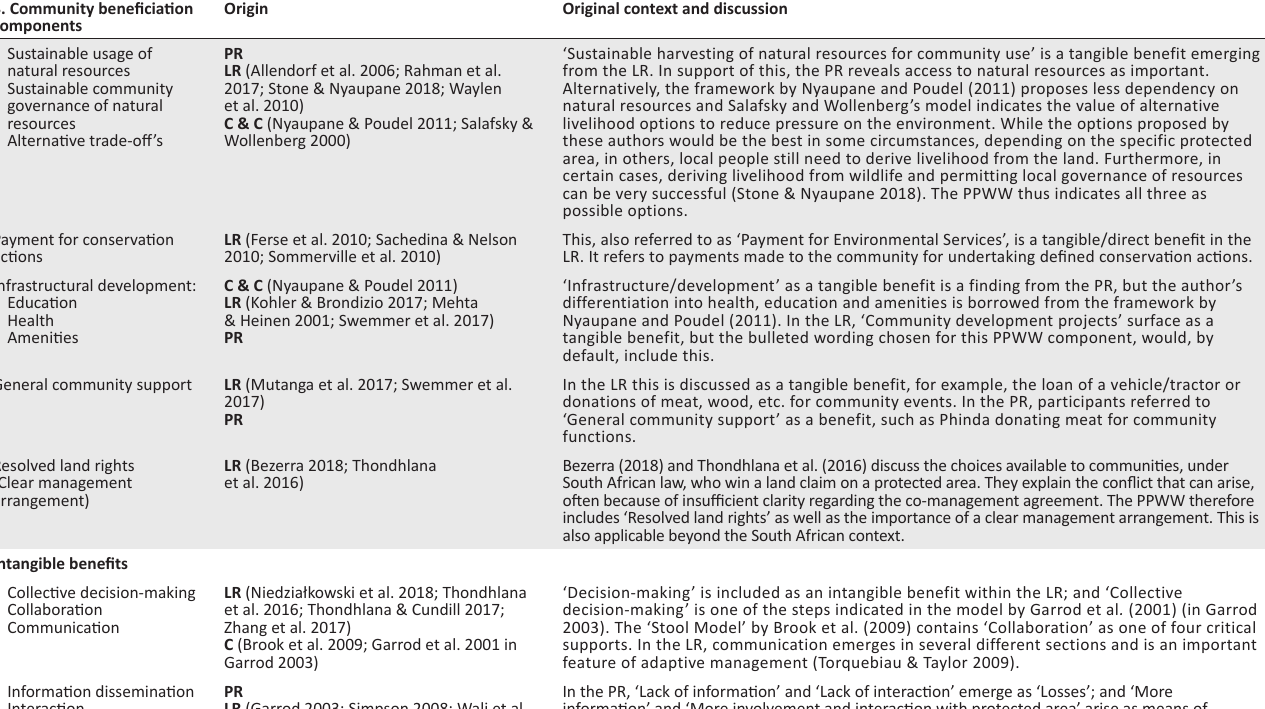
TABLE 3 (Continues…): Layer 3 and components used to build the People Parks Win-Win